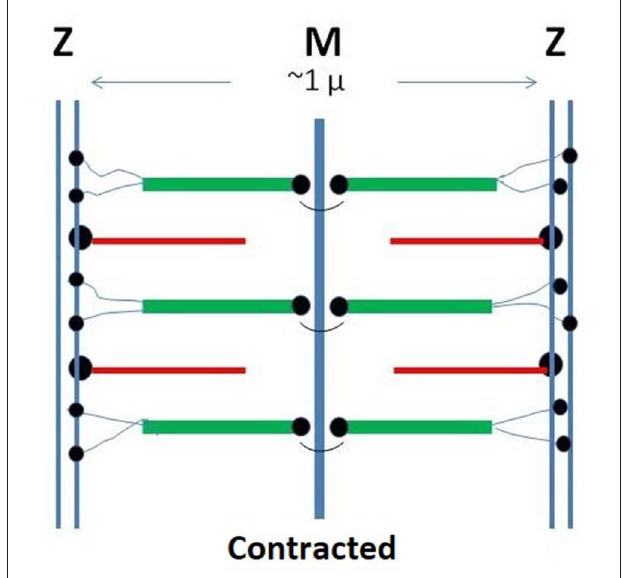
FIGURE 1 | Schematic representation of the monomeric sarcomer. Two half sub-units are specularly connected at the M-line. Within each sub-sarcomer, the trajectory of titin span from the M to the Z-zone. The thick filaments are based on rigid myosin bound to three to six tinin molecules. The thin filaments are based on rigid actin bound tropomyosin and troponin and anchored to the Z-zone by the cross-linking protein α -actinin. Red: thin filaments: Green: thick filaments; Black: tinin; Yellow: